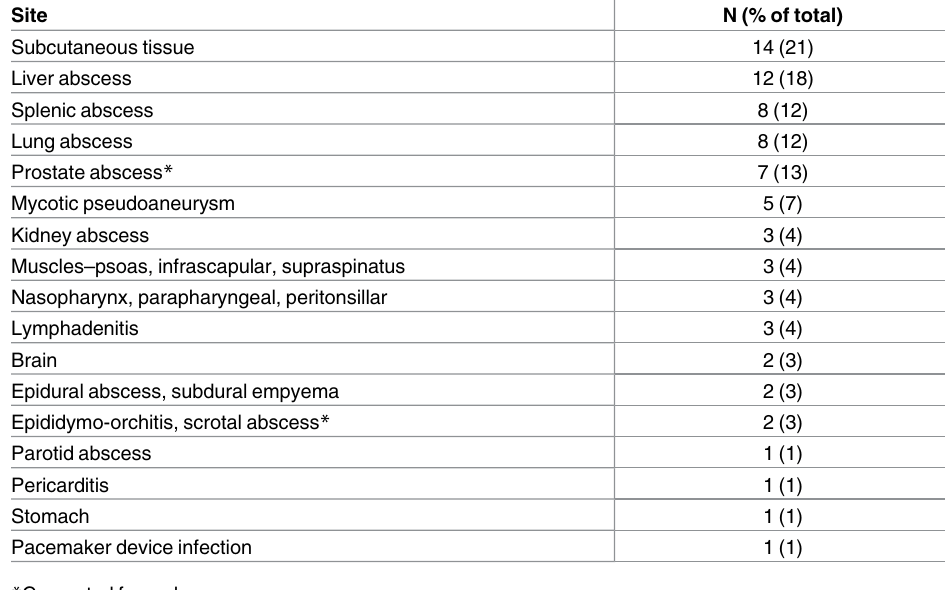
Table 5. Internal organ abscesses and other soft tissue